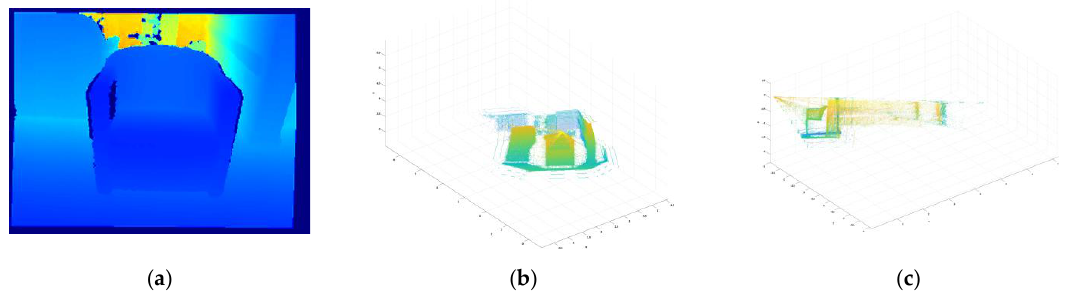
Figure 5. Results of cubic interpolation (INTER_CUBIC) of the depth image (PSNR = 34.515 dB). ( a ), depth image; ( b ), front view of the point cloud map of the depth image; ( c ), side view of the point cloud map of the depth image.